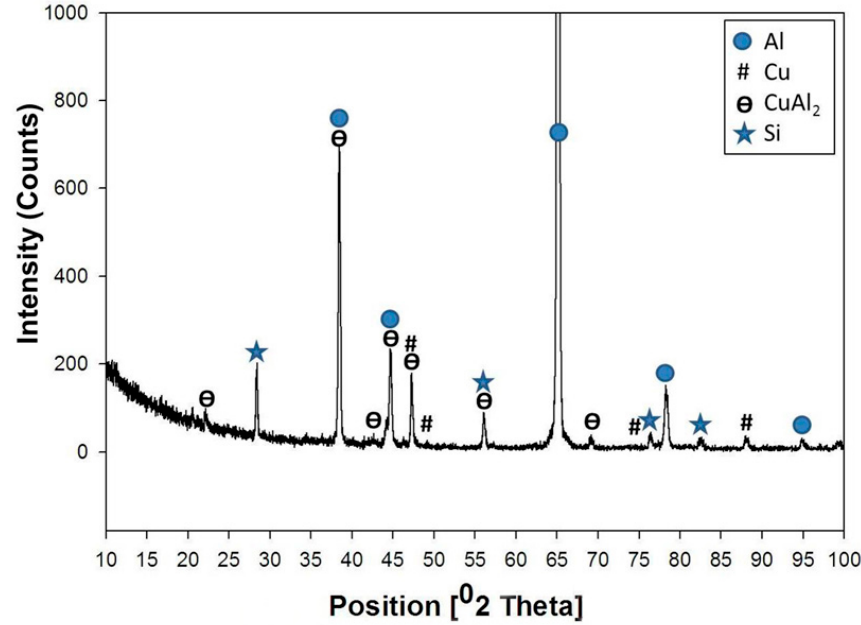
Figure 2. X-ray diffractometer (XRD) patterns obtained from of the formed composite after addition of 3% Cu.